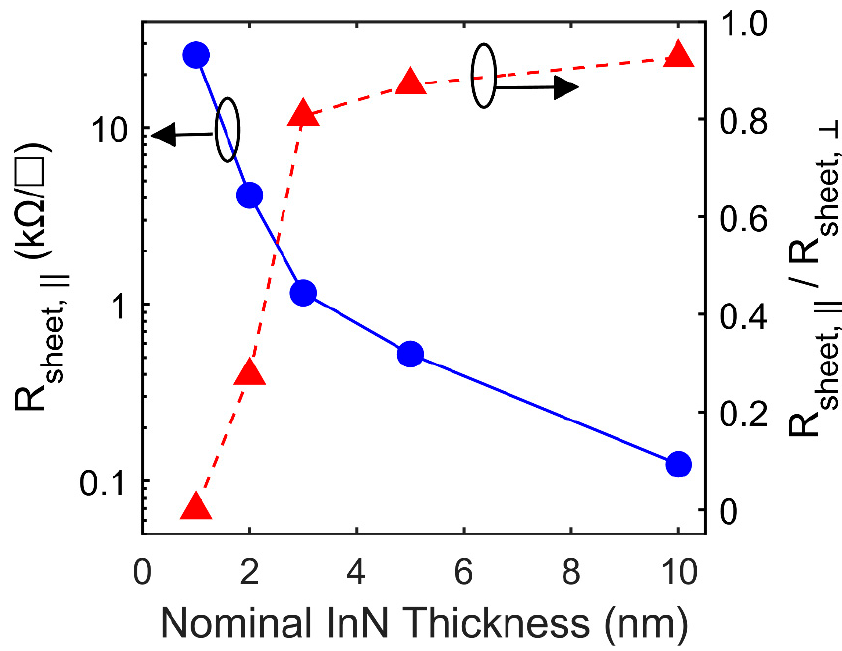
Figure 5. DC TLM data for processed samples from the N-polar InN thickness series. The blue curve indicates the sheet resistance parallel to the wire segment direction. The red curve indicates the ratio of sheet resistance parallel to the wire segment direction and sheet resistance perpendicular to the wire segment direction.